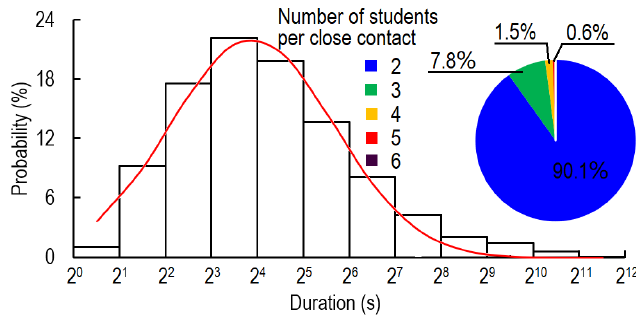
Figure 6. Probability distribution of duration per close contact.